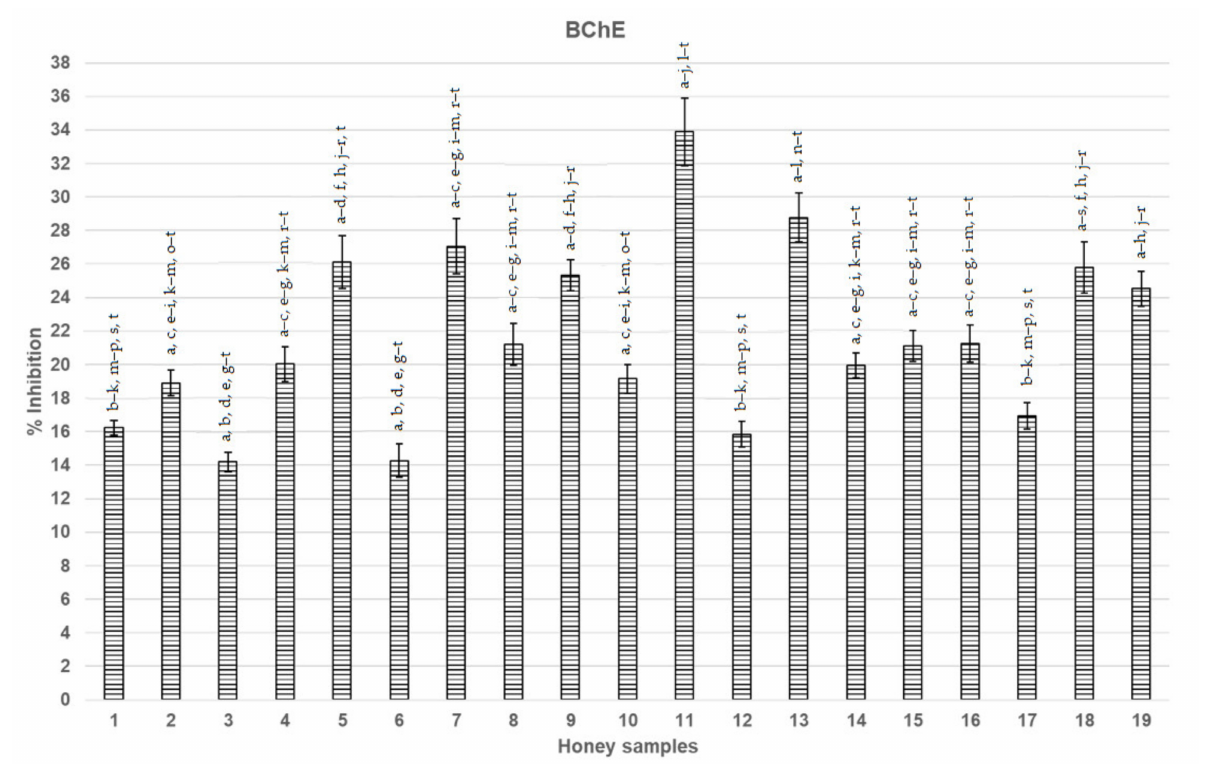
Figure 3. BChE inhibition (%) in the studied honeys (averaged results ± standard deviation).